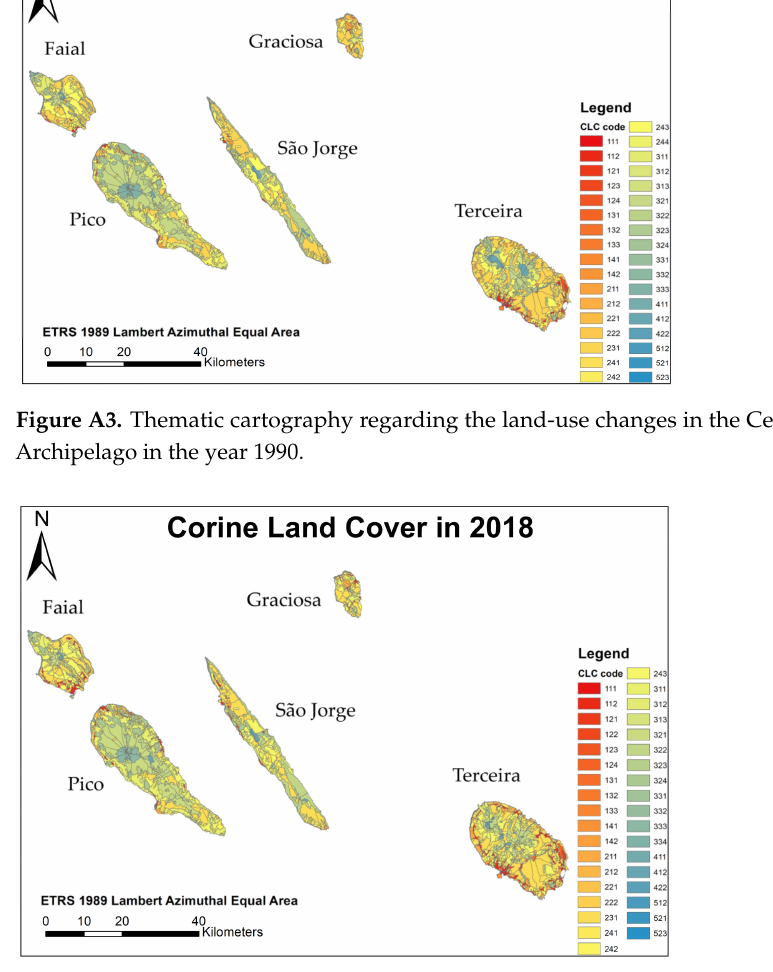
Figure A4. Thematic cartography regarding the land-use changes in the Central Group of Azores Archipelago in the year